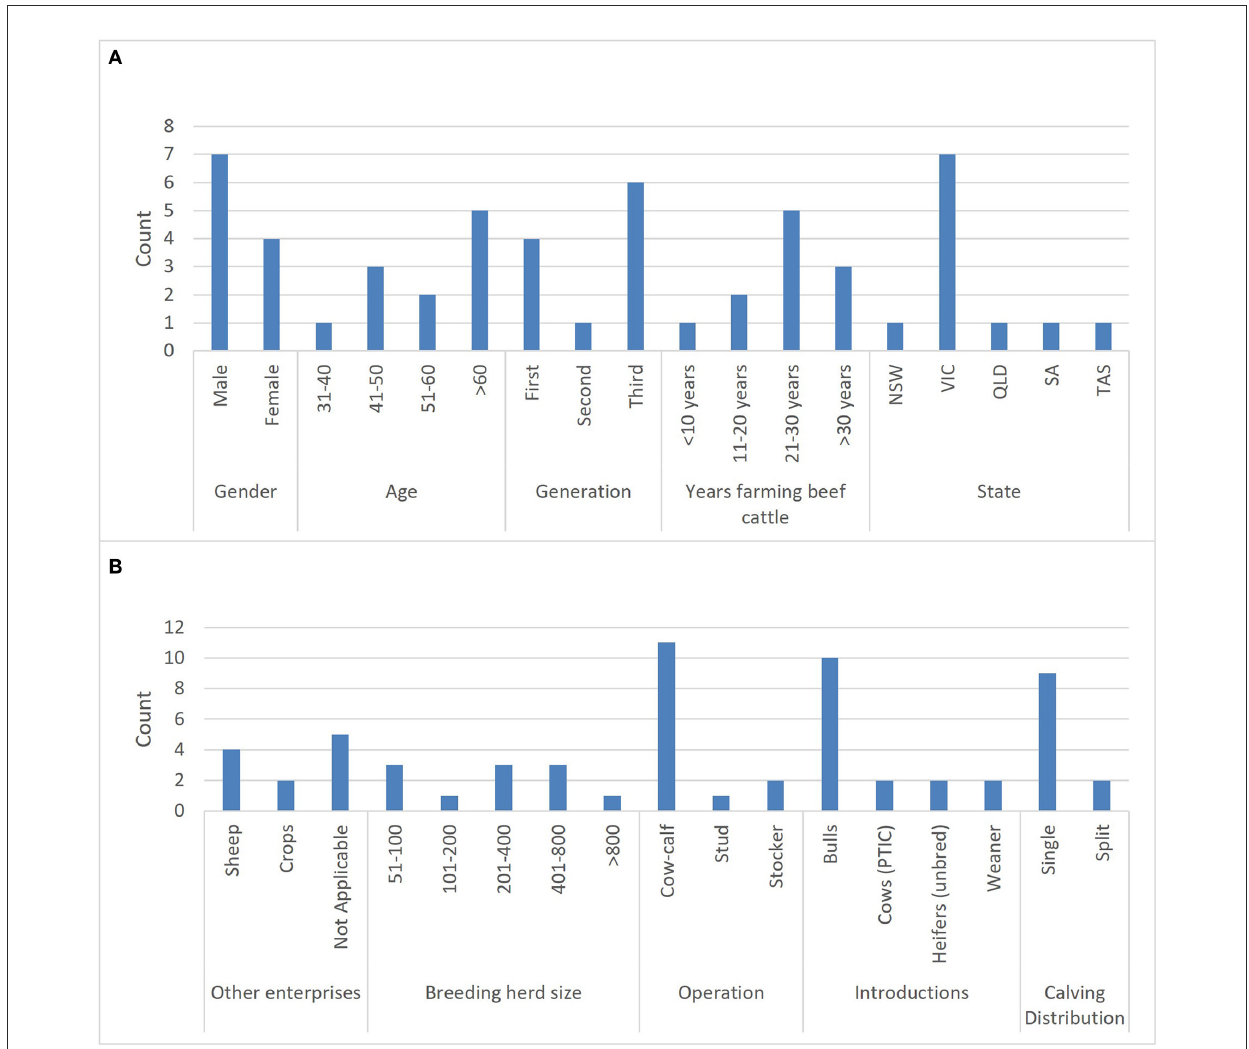
FIGURE2 Barplots illustrating counts of the demographics (A) and enterprise details (B) of Australian farmers participating in semi-qualitative interviews. NSW, New South Wales; VIC, Victoria; QLD, Queensland; SA, South Australia; TAS, Tasmania; PTIC, Pregnancy tested in-calf.